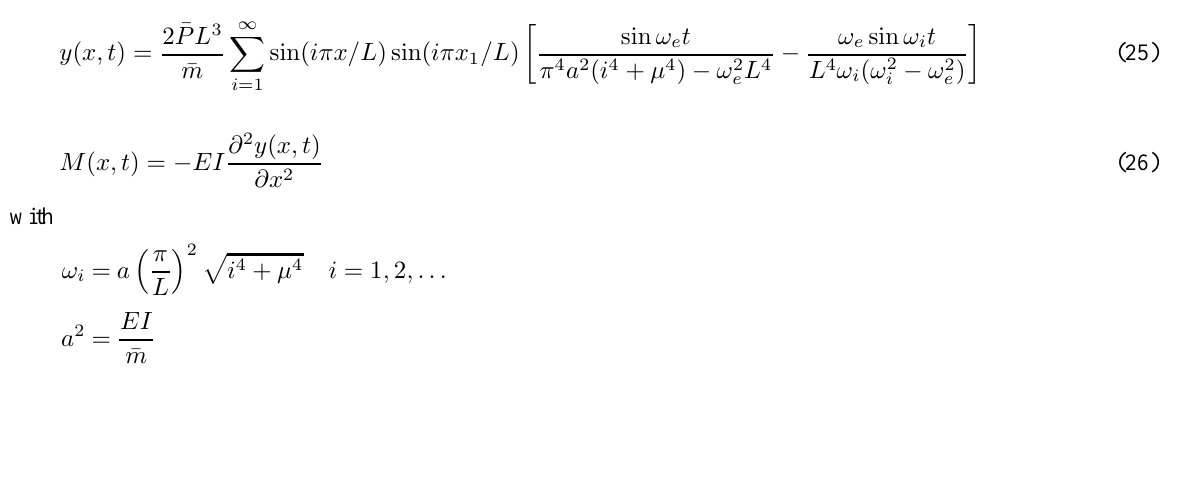
Fig. 11. Time histories for bending moment at the midpoint cross-section of beam with the solutions given by the proposed formula and by the conventional formula with 6 elements. beam. The expressions of the exact vertical displacement y ( x, t ) and bending moment M ( x, t ) of the beam taken from Timoshenko et al. [22] are as